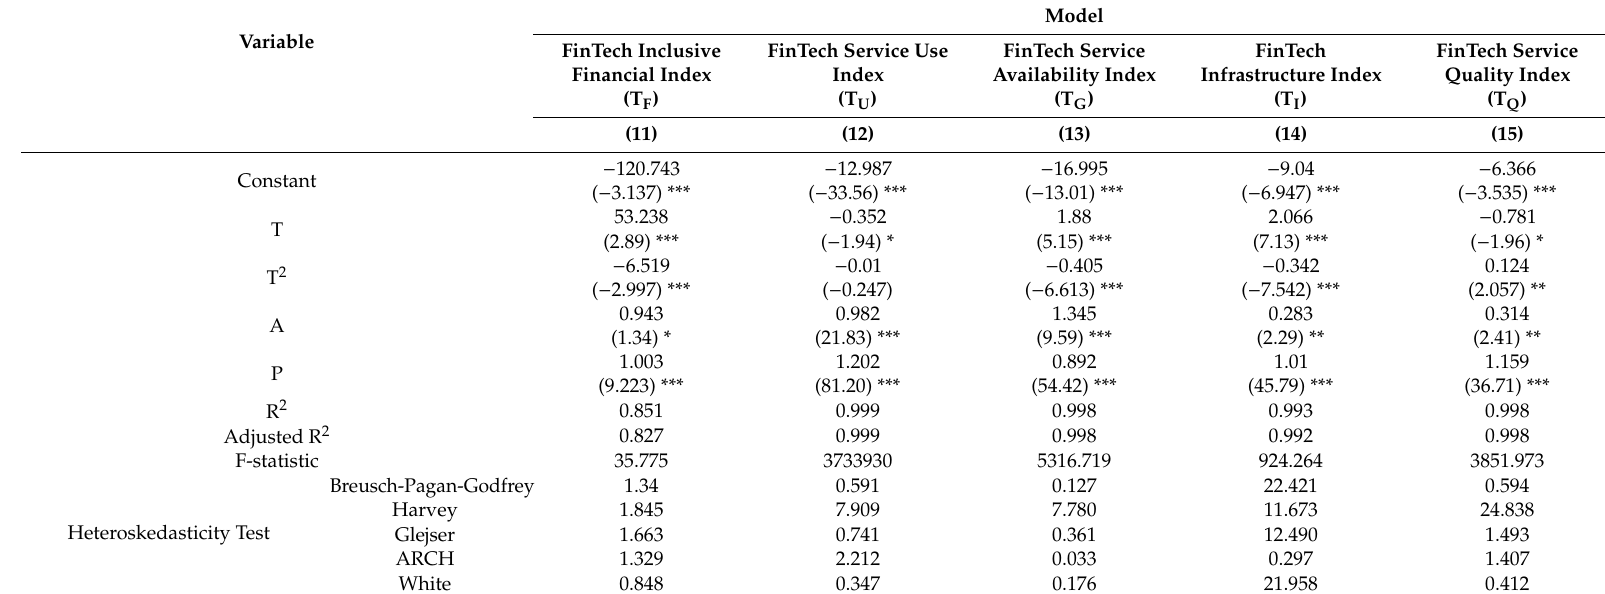
Table 4. Estimation of the impact of FinTech on NPS